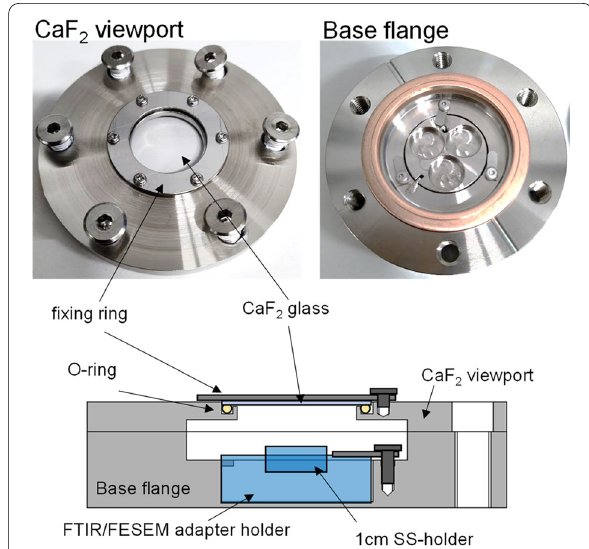
Fig. 9 Schematic diagram and photographs of the CaF 2 viewport, which was made from a ConFlat flange. The CaF 2 window is 25 mm in diameter, and the effective diameter is 20